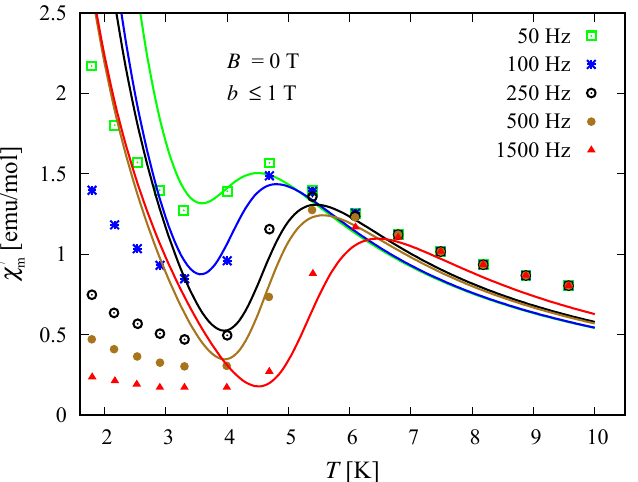
Figure 8. Temperature dependence of the in-phase susceptibility for the compound Na 9 [Er(W 5 O 18 ) 2 ]. The symbols depict the experimental data from Reference [9]. The theoretical results obtained with the aid of the spin–sigma model (1) and (12), at an amplitude of the ac field b ≤ 1, are presented with solid lines.